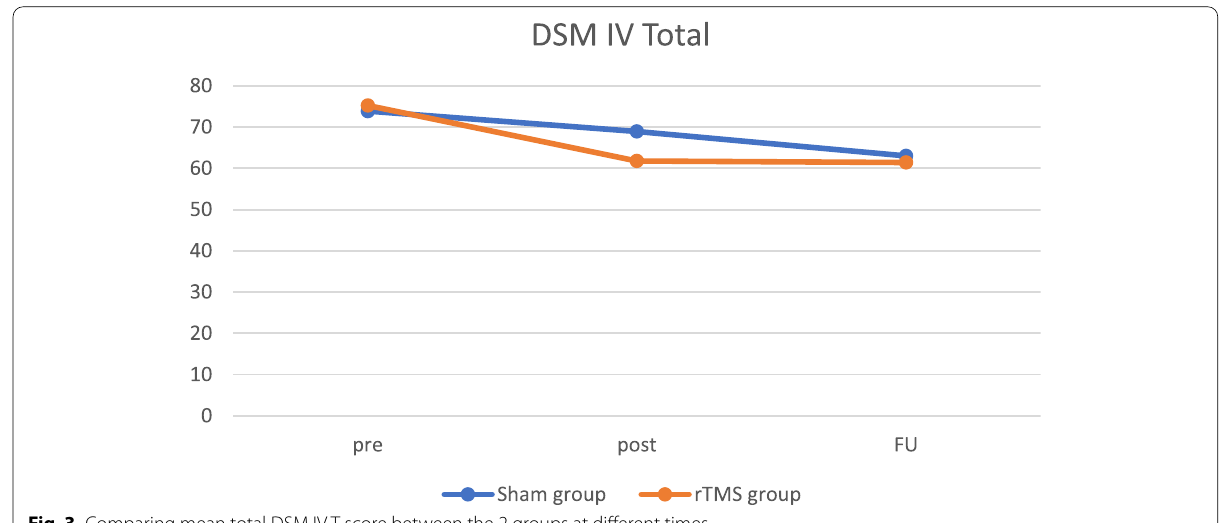
Fig. 3 Comparing mean total DSM IV T score between the 2 groups at different times